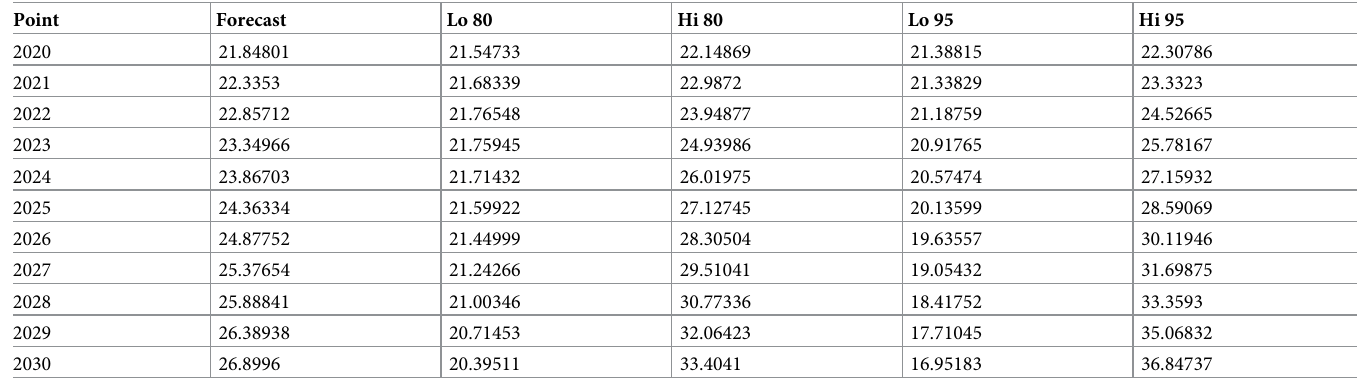
Table 7. Forecast value for employment rate using ARIMA (1,2,1).